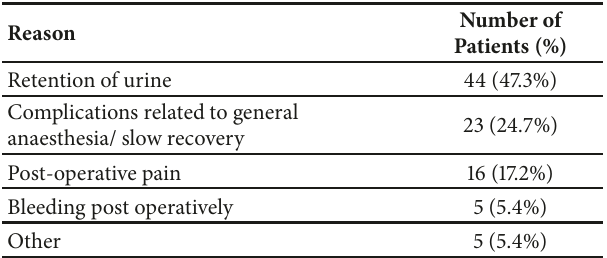
Number of Patients (%)